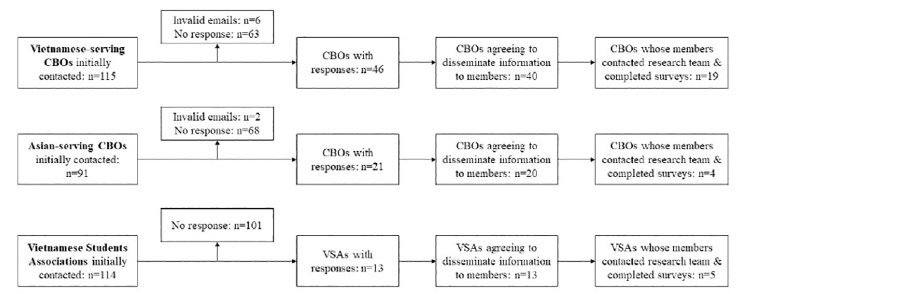
Fig 1. Recruitment process with community-based